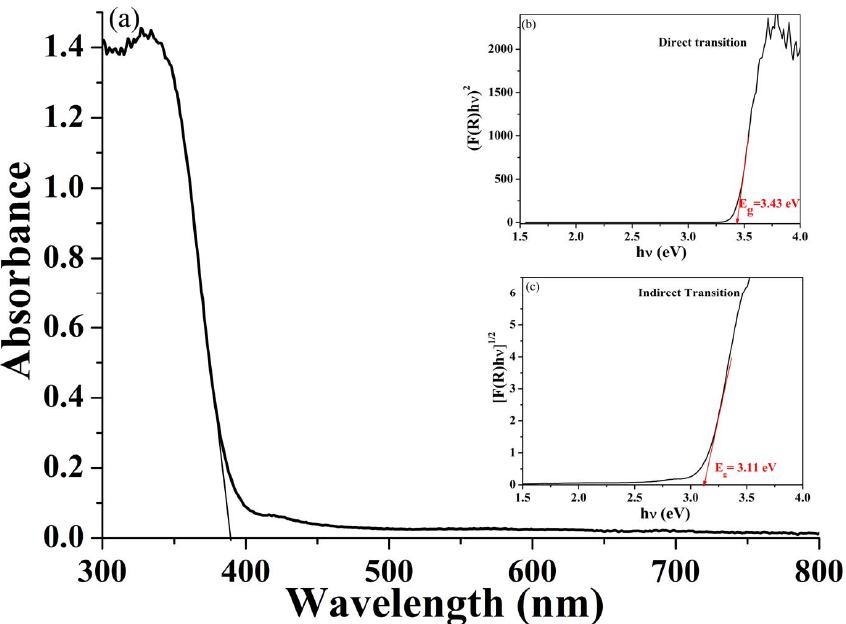
Figure 4. ( a ) UV−Vis diffuse reflectance spectrum of TiO 2 nanoparticles; ( b ) (F(R)hν) 2 vs. energy of the adsorbed light plot considering TiO 2 as a direct semiconductor; and ( c ) (F(R)hν) 1/2 vs. energy of the adsorbed light plot considering TiO 2 as an indirect semiconductor.